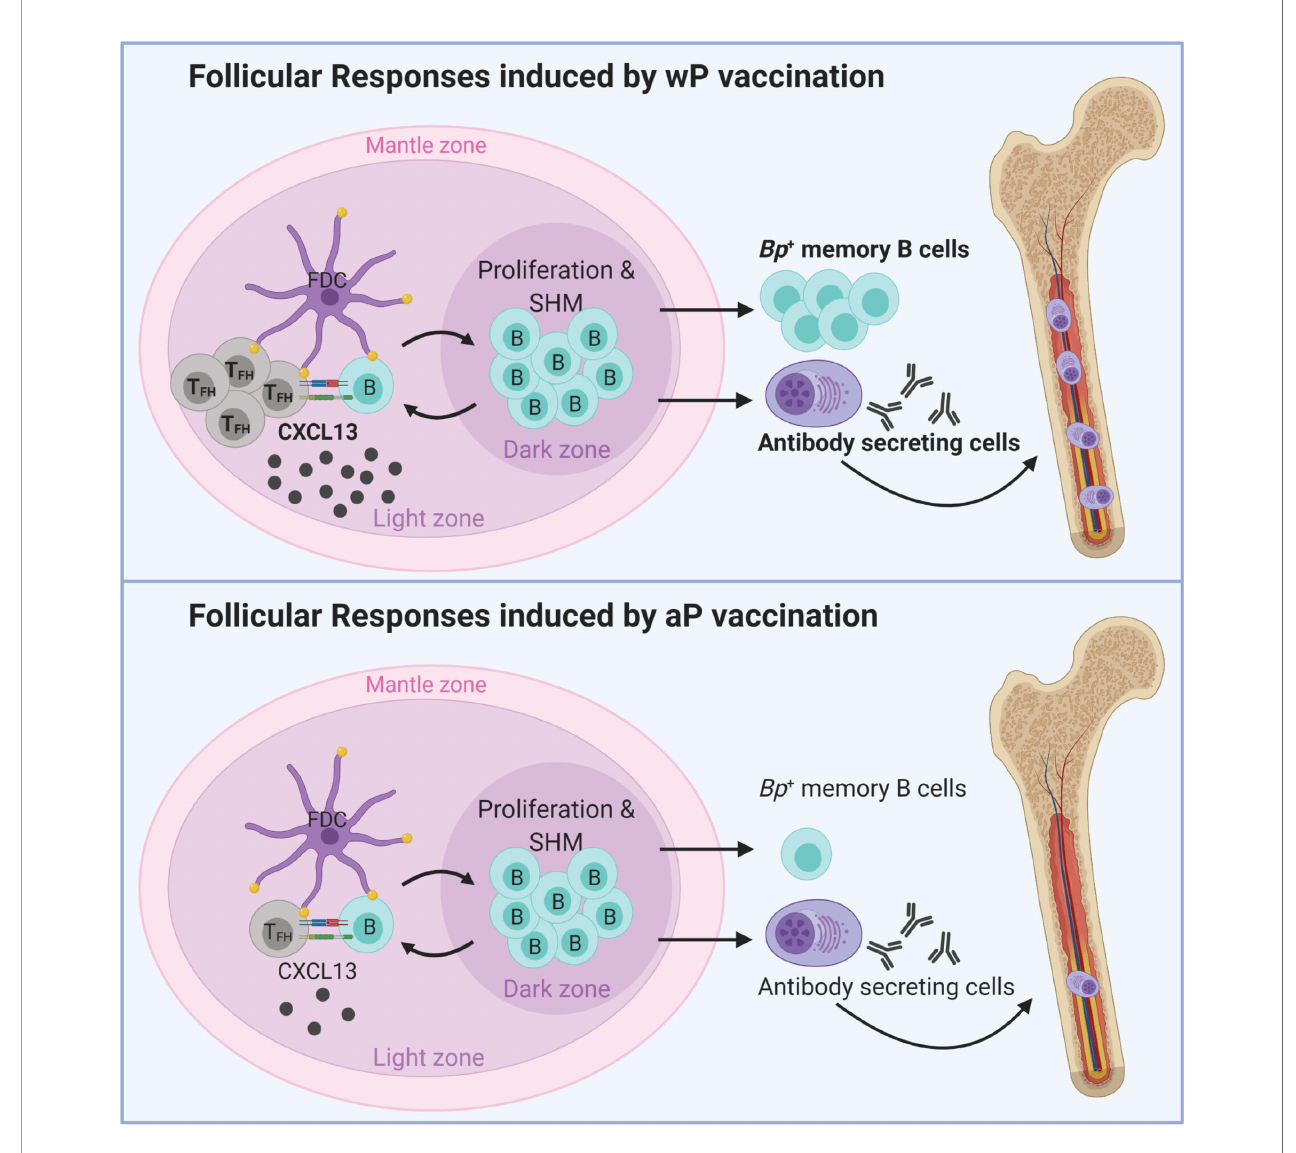
FIGURE 6 | Model of vaccination and follicular responses highlighting differences in aP versus wP immunization. Created with